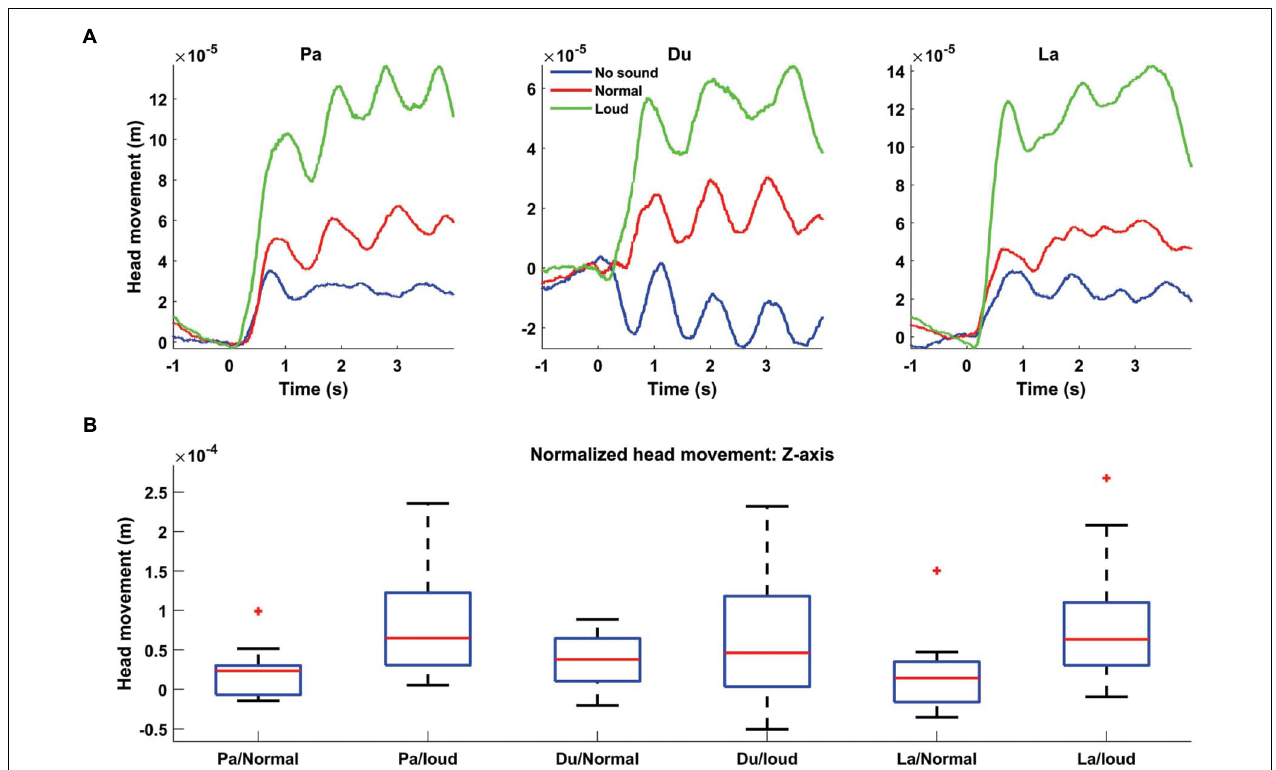
FIGURE 3 | Grand averaged head movement modulated by different syllables and speech loudness. (A) Head movement in the Z-axis direction is plotted for all three syllables: Pa (left panel), Du (middle panel), and La (right panel) with different loudness levels [No-sound (blue), normal (red) and loud (green)]. The level of head movement is directly linked to the speech loudness. (B) Boxplots showing the distribution of averaged head movement, for the first 4 s after pronunciation onset, normalized by subtracting No-sound condition from other loudnesses. For all three syllables, higher loudness caused the stronger head movement.